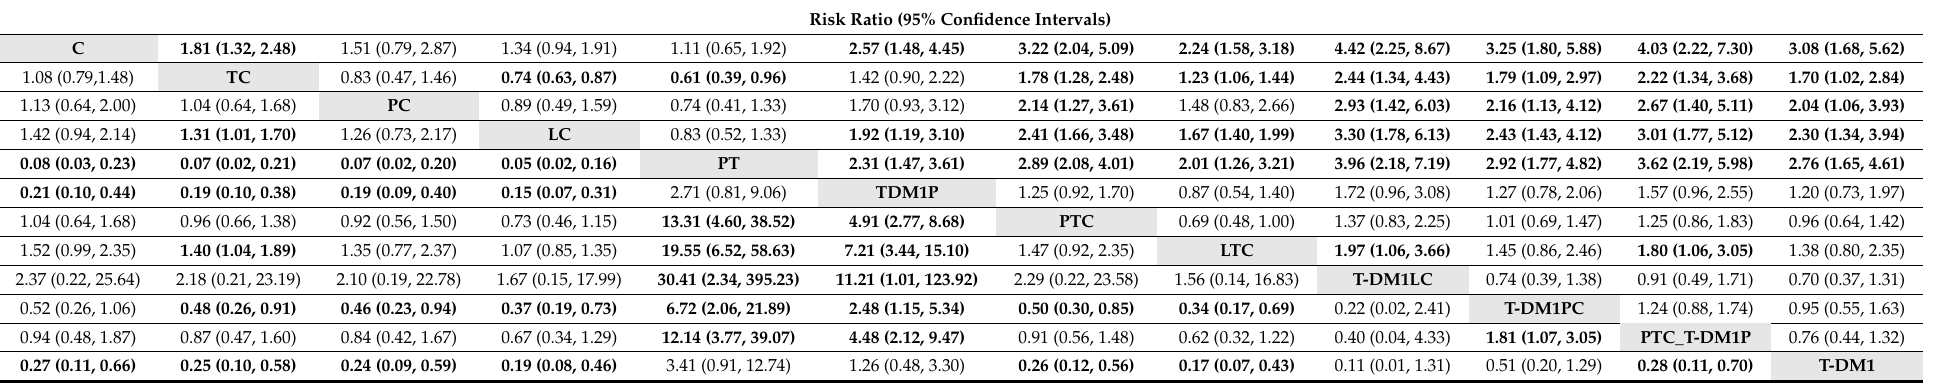
Results of treatment comparisons are read from right to left. For example, the risk ratio (95% confidence intervals) for pCR of TC vs. C is 1.81 (1.32, 2.48) and the risk ratio (95% confidence intervals) for SAE of TC vs. C is 1.08 (0.79, 1.48). Bold font indicates significance. C = Chemotherapy; TC = Trastuzumab + chemotherapy; PC = Pertuzumab + chemotherapy; LC = Lapatinib + chemotherapy; PTC = Pertuzumab + trastuzumab + chemotherapy; LTC = Lapatinib + trastuzumab +chemotherapy; PT = Pertuzumab + trastuzumab; T-DM1P = trastuzumab emtansine + pertuzumab; T-DM1LC = trastuzumab emtansine +lapatinib + chemotherapy; T-DM1PC = trastuzumab emtansine + pertuzumab +